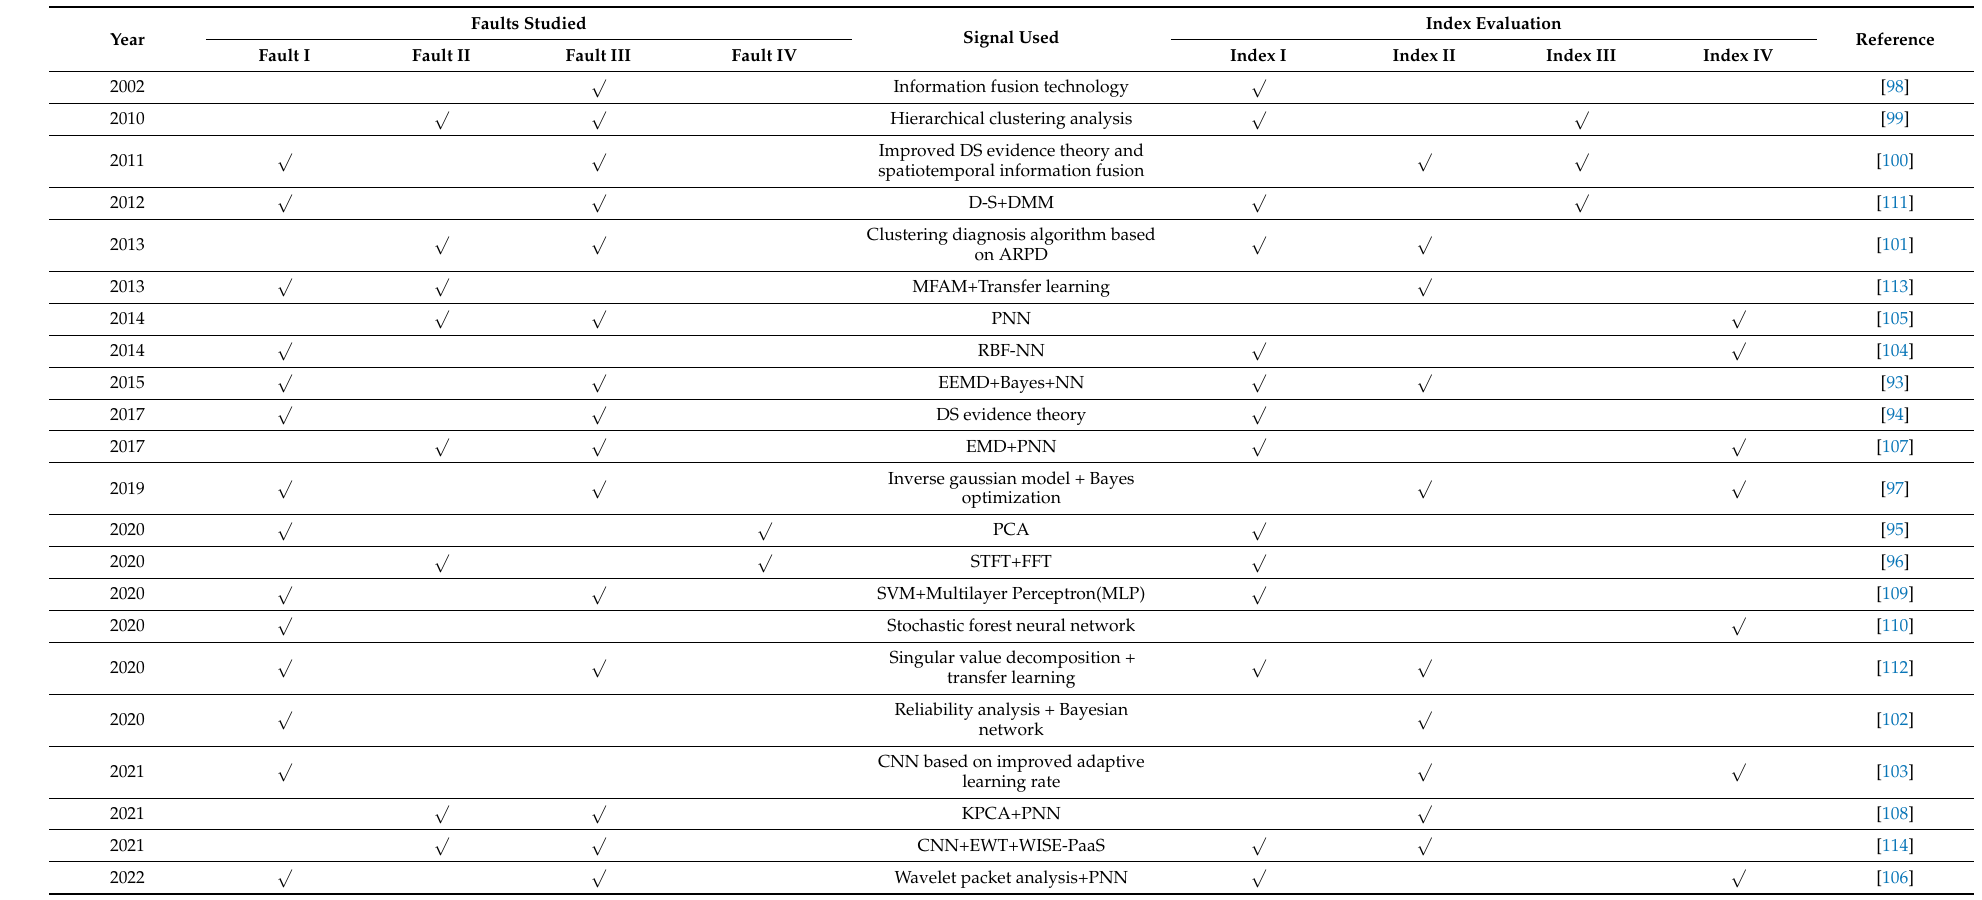
Table 3. Fault diagnosis method based on multiple